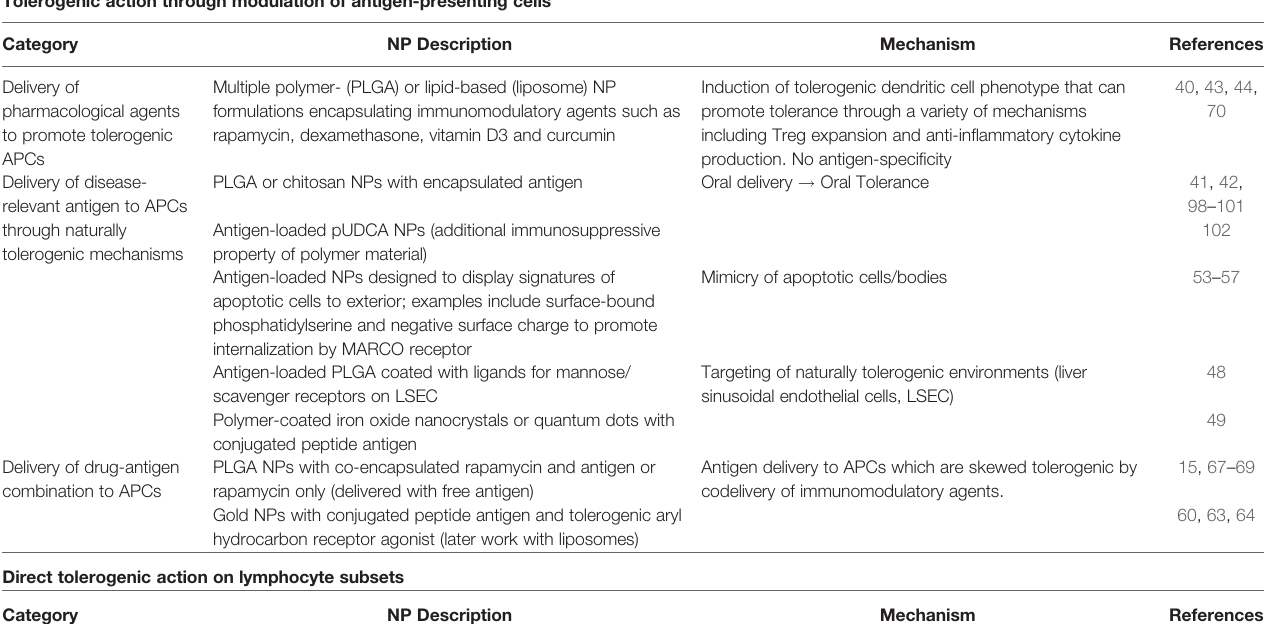
TABLE 1 | Different approaches employing nanoparticles therapies for tolerance induction. Tolerogenic action through modulation of antigen-presenting